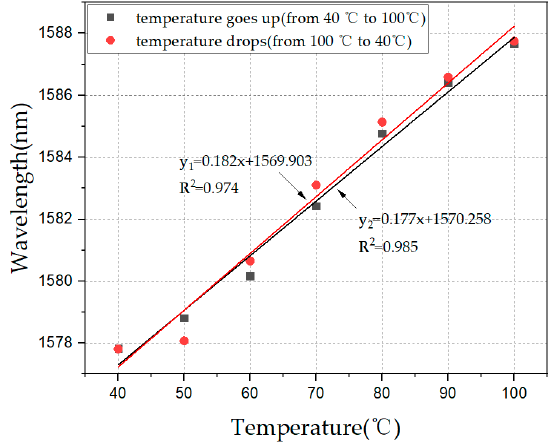
Figure 14. The sensitivity of the repeatability and stability of the sensor.